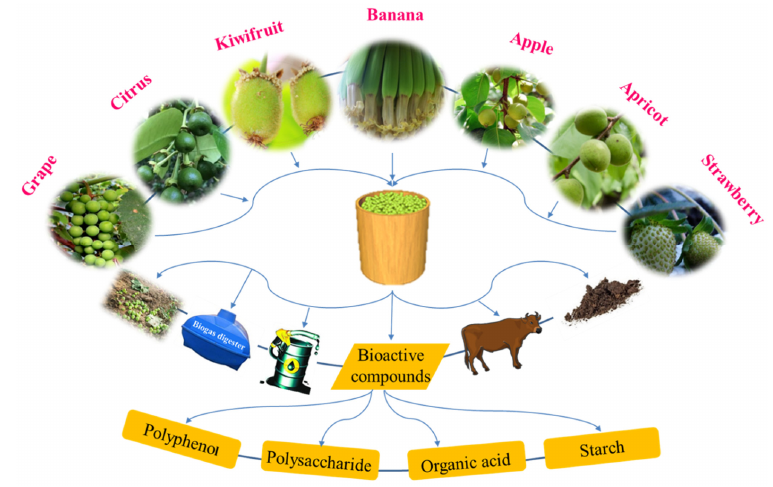
Figure 2. Utilization of thinned unripe fruit.